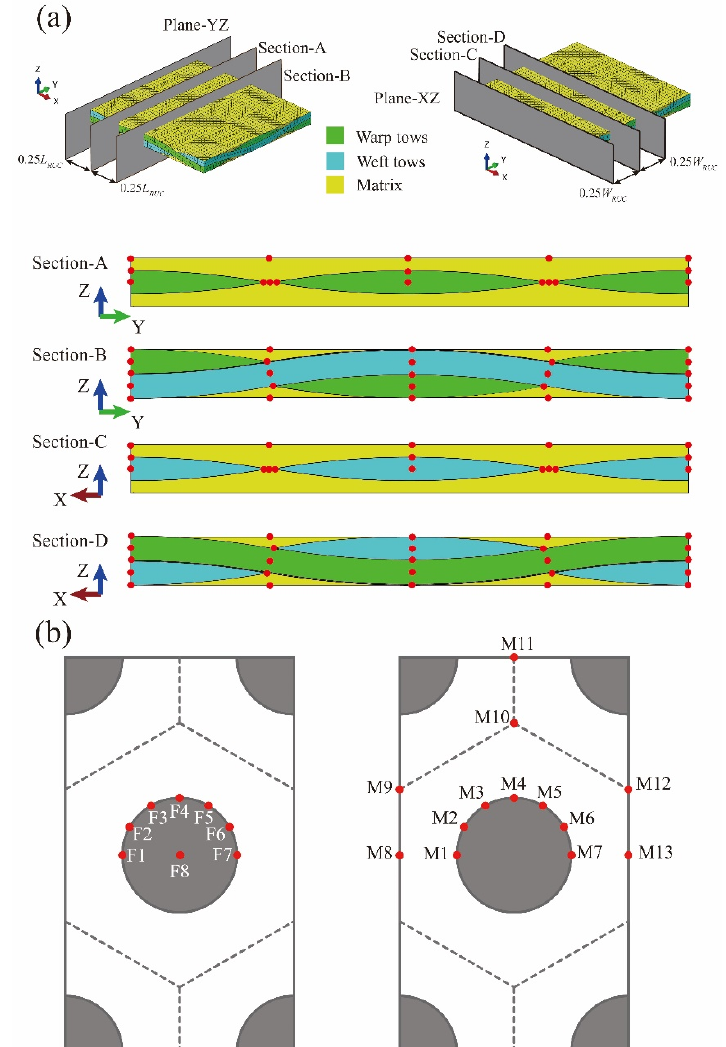
Figure 20. The choice of the reference points for the PWF composite: ( a ) reference points in the meso-scale FE model; ( b ) reference points in the micro-scale FE model.